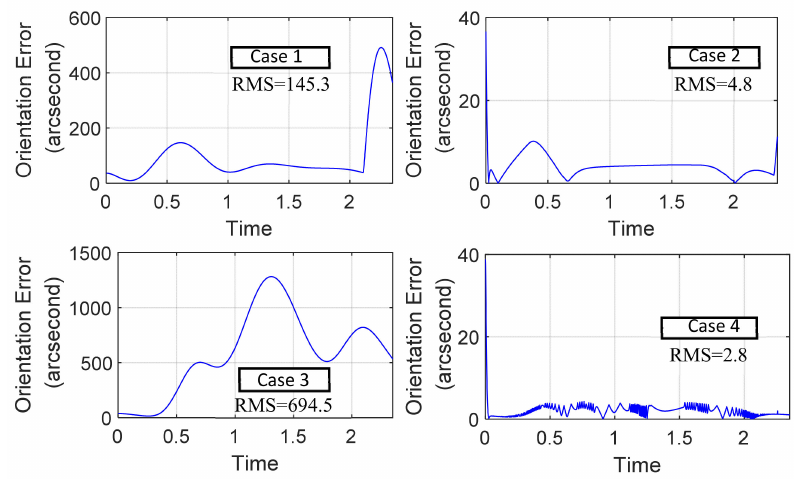
Figure 7. The orientation errors for the 4 simulation